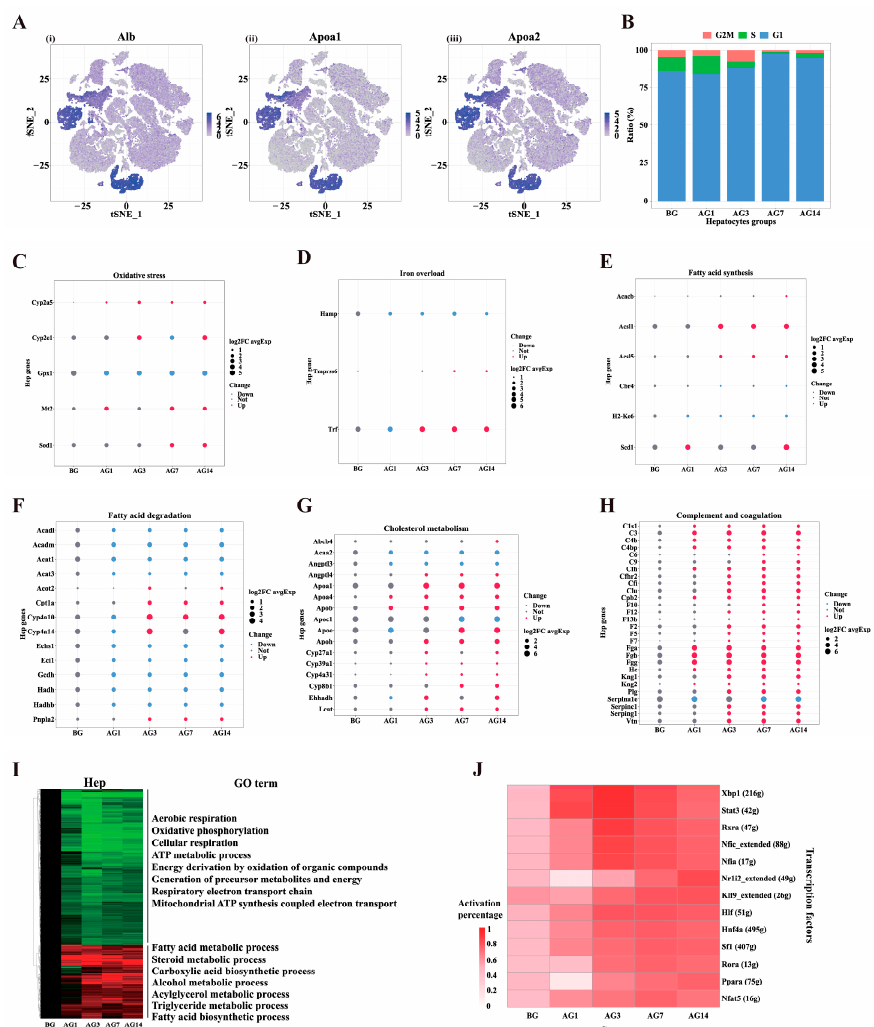
Figure 4. Effect of alcohol on gene expression in mouse hepatocytes. ( A ) Gene expression of hepatocyte markers, (i) Alb , (ii) Apoa1 , (iii) Apoa2 . Color bars indicate the expression level in log-scale UMI. ( B ) Distribution of cell cycle phases (G2/M, S, G1) in hepatocytes of different groups. ( C – H ) Dot plots showed the relative expression changes of genes related to oxidative stress, iron overload, fatty acid synthesis, fatty acid degradation, cholesterol metabolism, complement and blood coagulation in different groups of hepatocytes. The size represents the average Log2FC value compared to the BG group. ( I ) Differential expressed genes and GO terms between AG1, AG3, AG7and AG14 compared to BG in hepatocytes. ( J ) Heatmap of the percentage of cells with the regulon active in different groups of